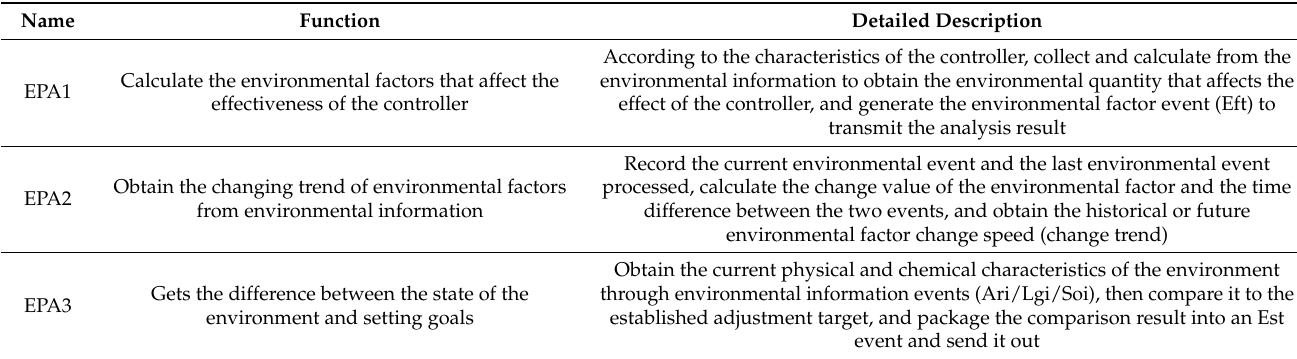
Table 4. EPA function